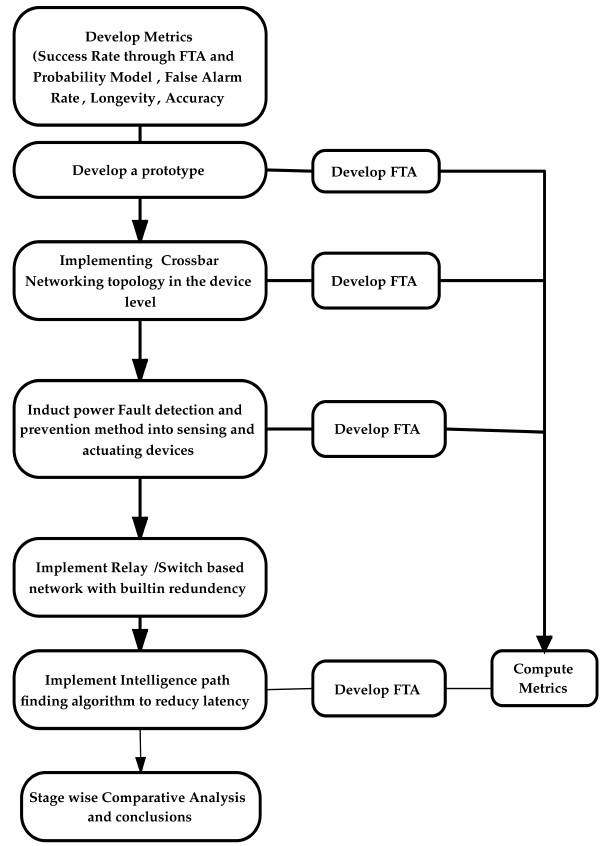
Figure 1. Overall method for improving the fault tolerance of the IoT